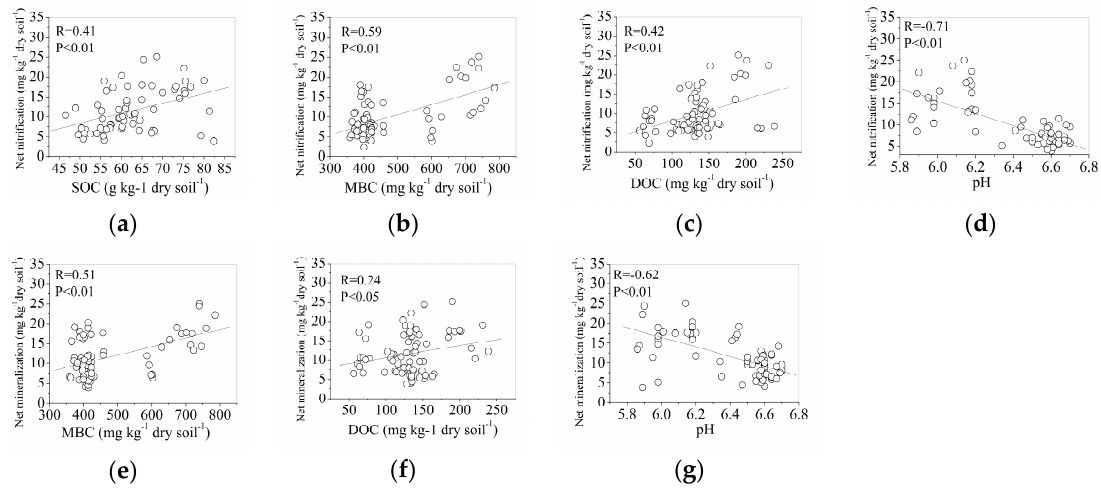
Figure 6. Correlations between net nitrification rates to SOC ( a ), MBC ( b ), DOC ( c ), and pH ( d ), and correlations between net N mineralization rates to MBC ( e ), DOC ( f ), and pH ( g ); the SOC, TN, MBC, DOC and MBC were determined in the beginning of each one-month incubation period, and the data represent the whole experimental period (from May to November) among forest types ( n = 72).